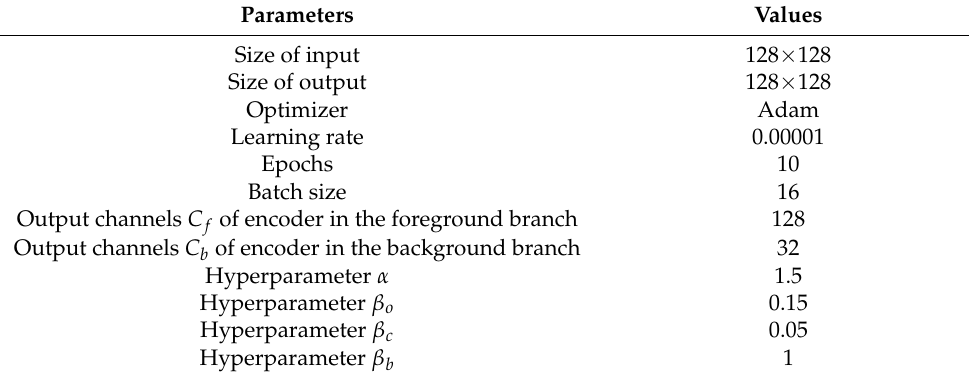
Table 1. The hyperparameter settings on the YouTube Objects dataset.